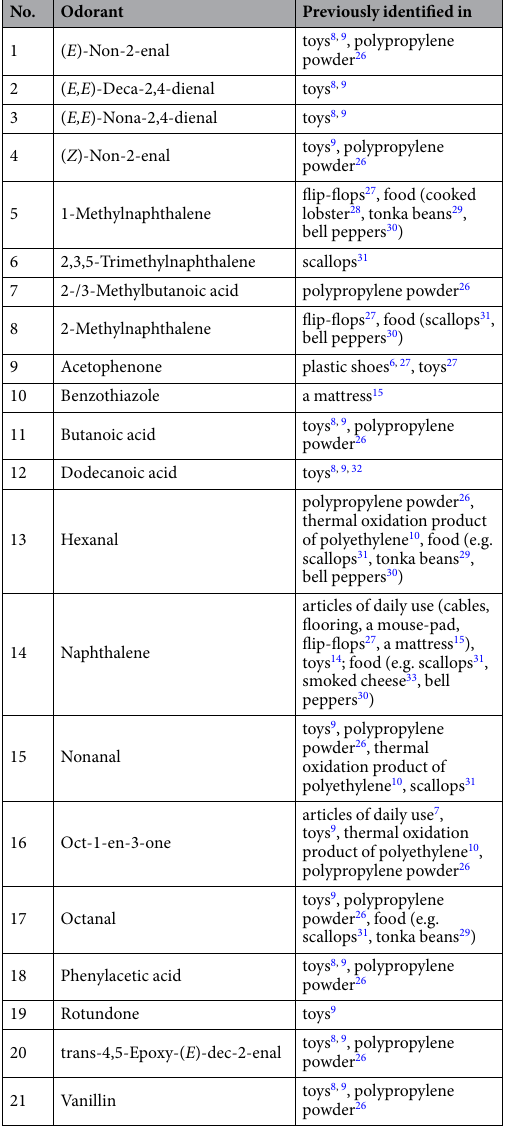
Table 3. Examples for the occurrence of identified odorants in other products or